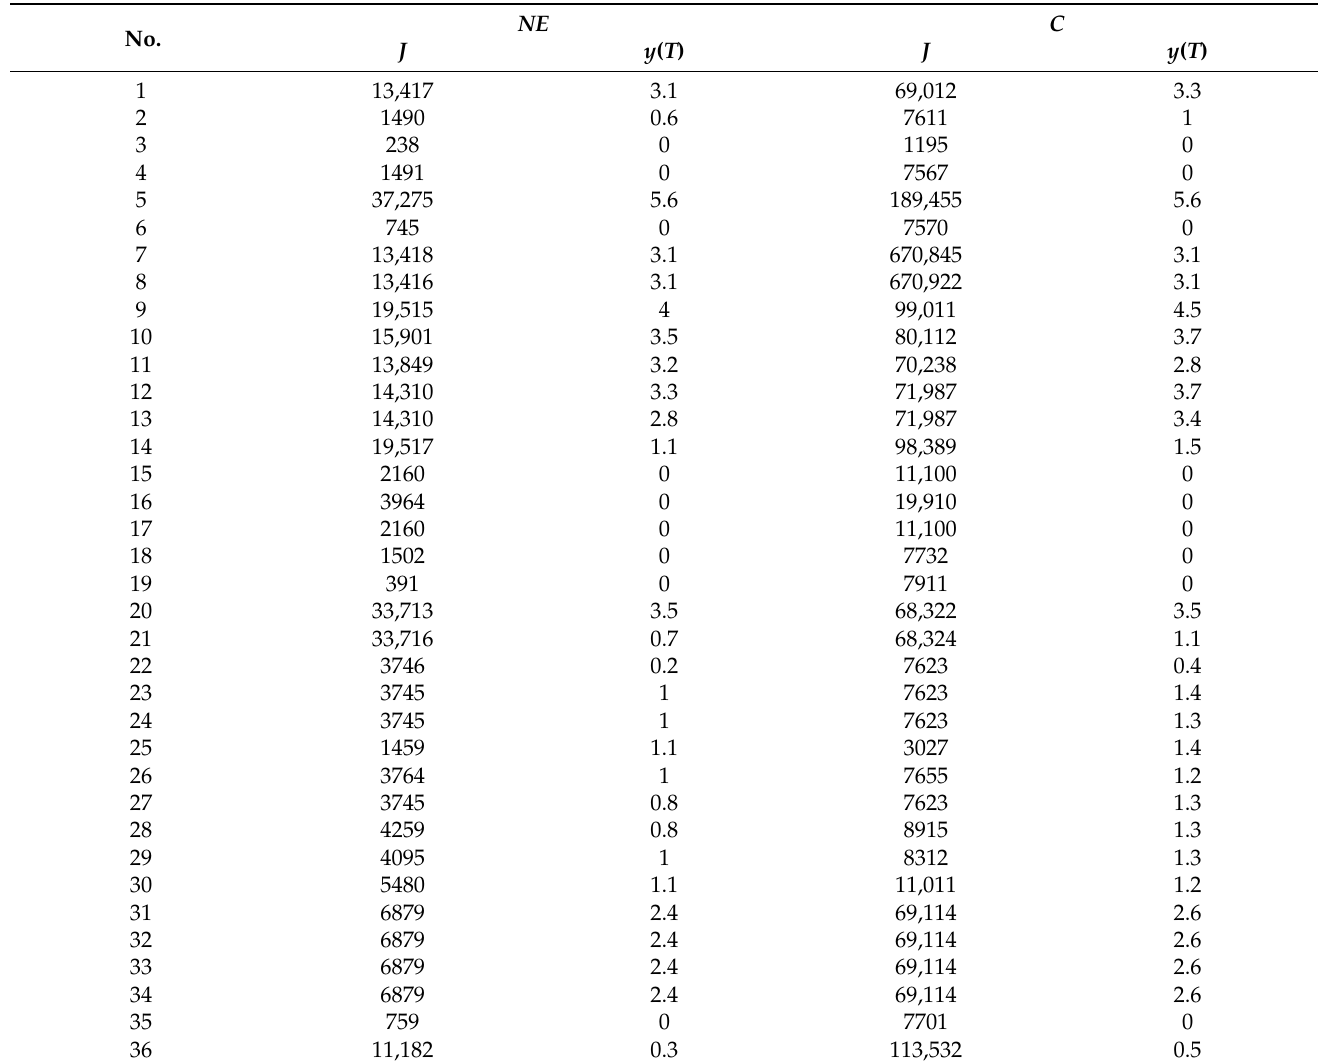
Table 7. Payoffs for different information structures for symmetrical agents with consideration of the green effect.